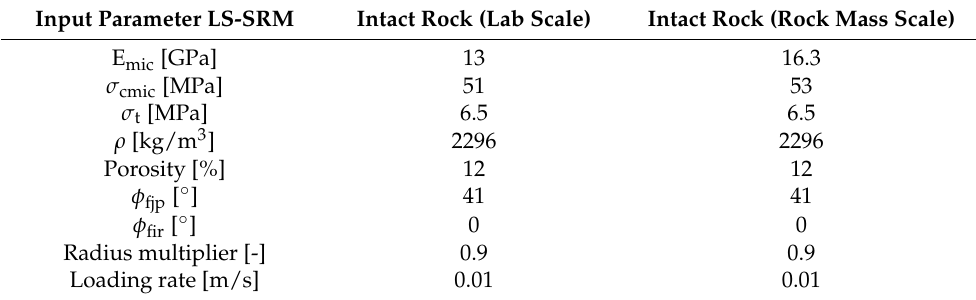
Table 3. Lattice input parameters for intact rock and rock mass